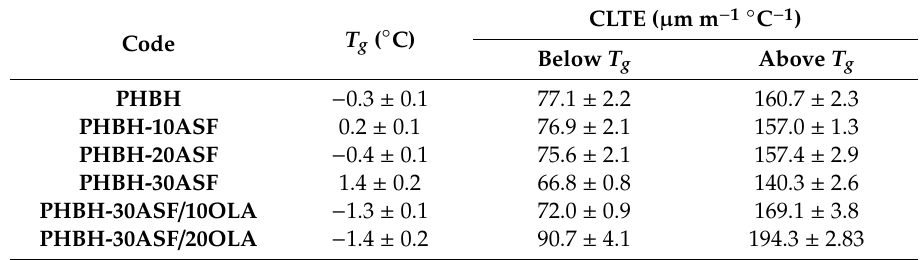
Table 6. Summary of the main thermo mechanical properties of neat PHBH and PHBH-ASF / OLA with di ff erentcompositions, regardingthethermalexpansion,